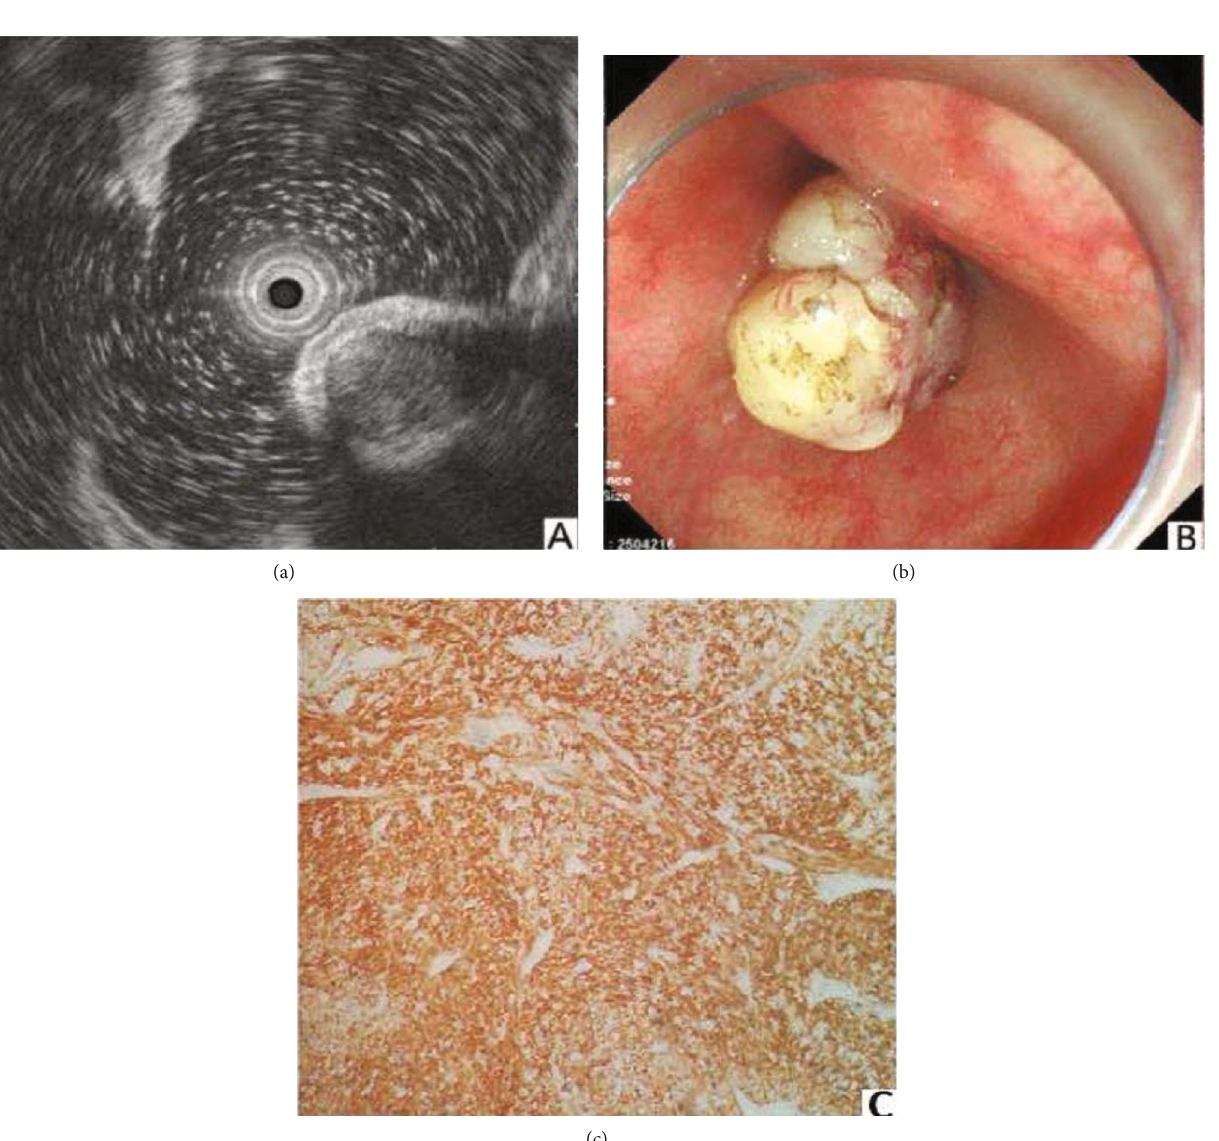
Figure 3: GIST was demonstrated as a round, uniform hyperechoic lesion of muscularis propria (a, b) and CD117(+) or CD34(+) and SMA(-)